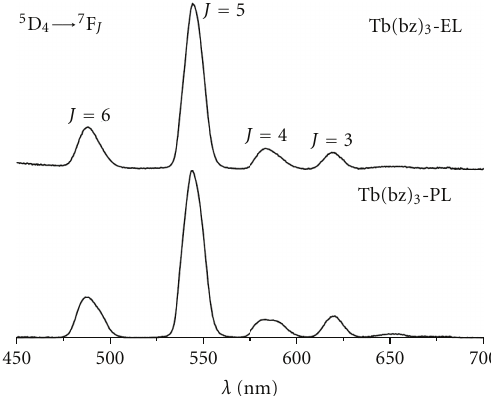
Figure 3: Normalized EL and PL spectra ( λ ex = 337 nm) of Tb(bz) 3